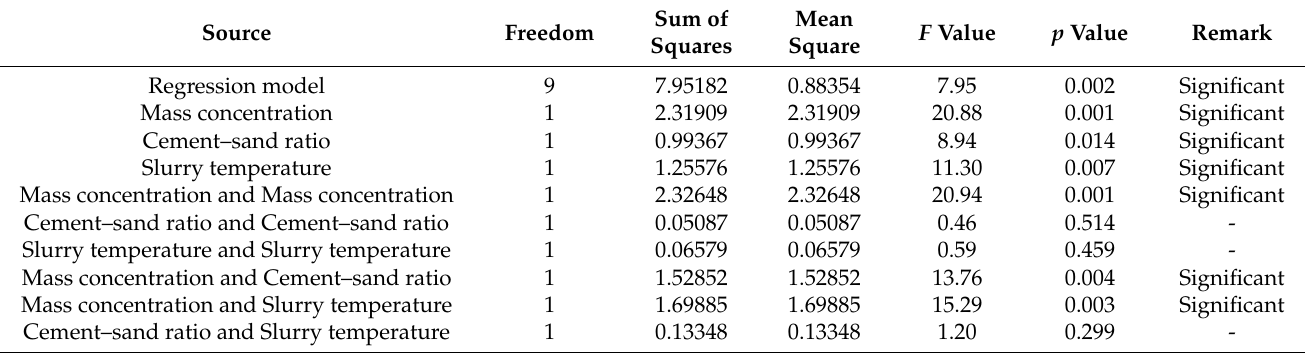
Table 10. Variance analysis of endogenous response surface